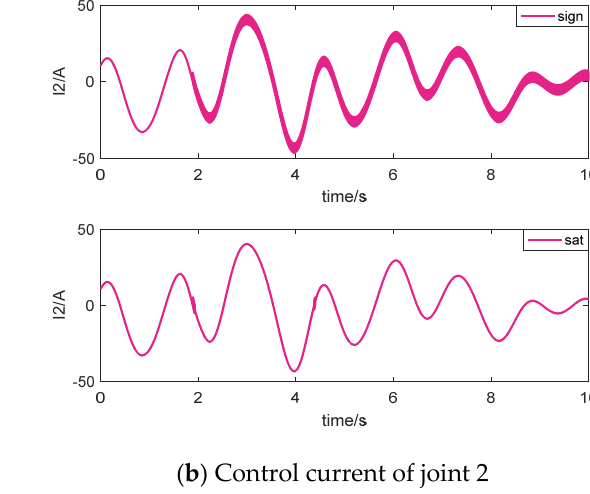
Figure 10. Tracking performances and vibration suppression of the manipulator with uncertainties.